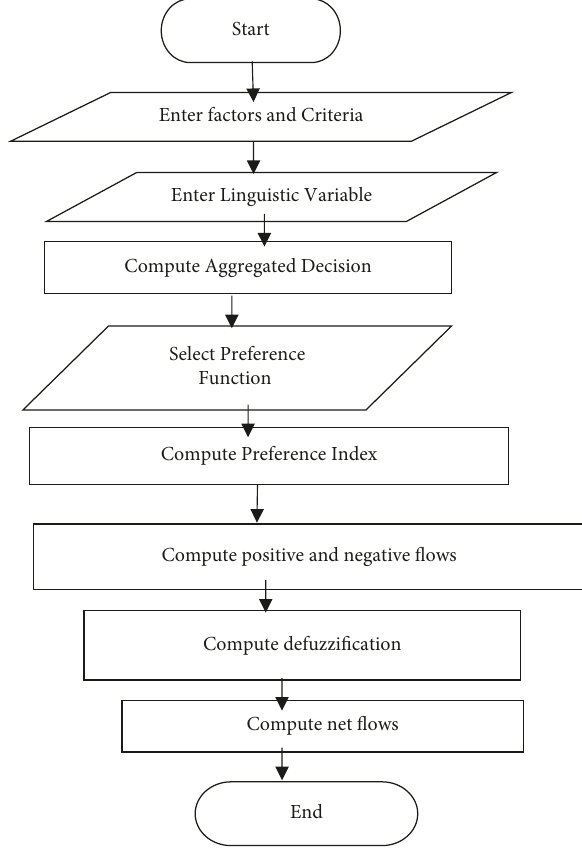
Figure 1: Flowchart of fuzzy